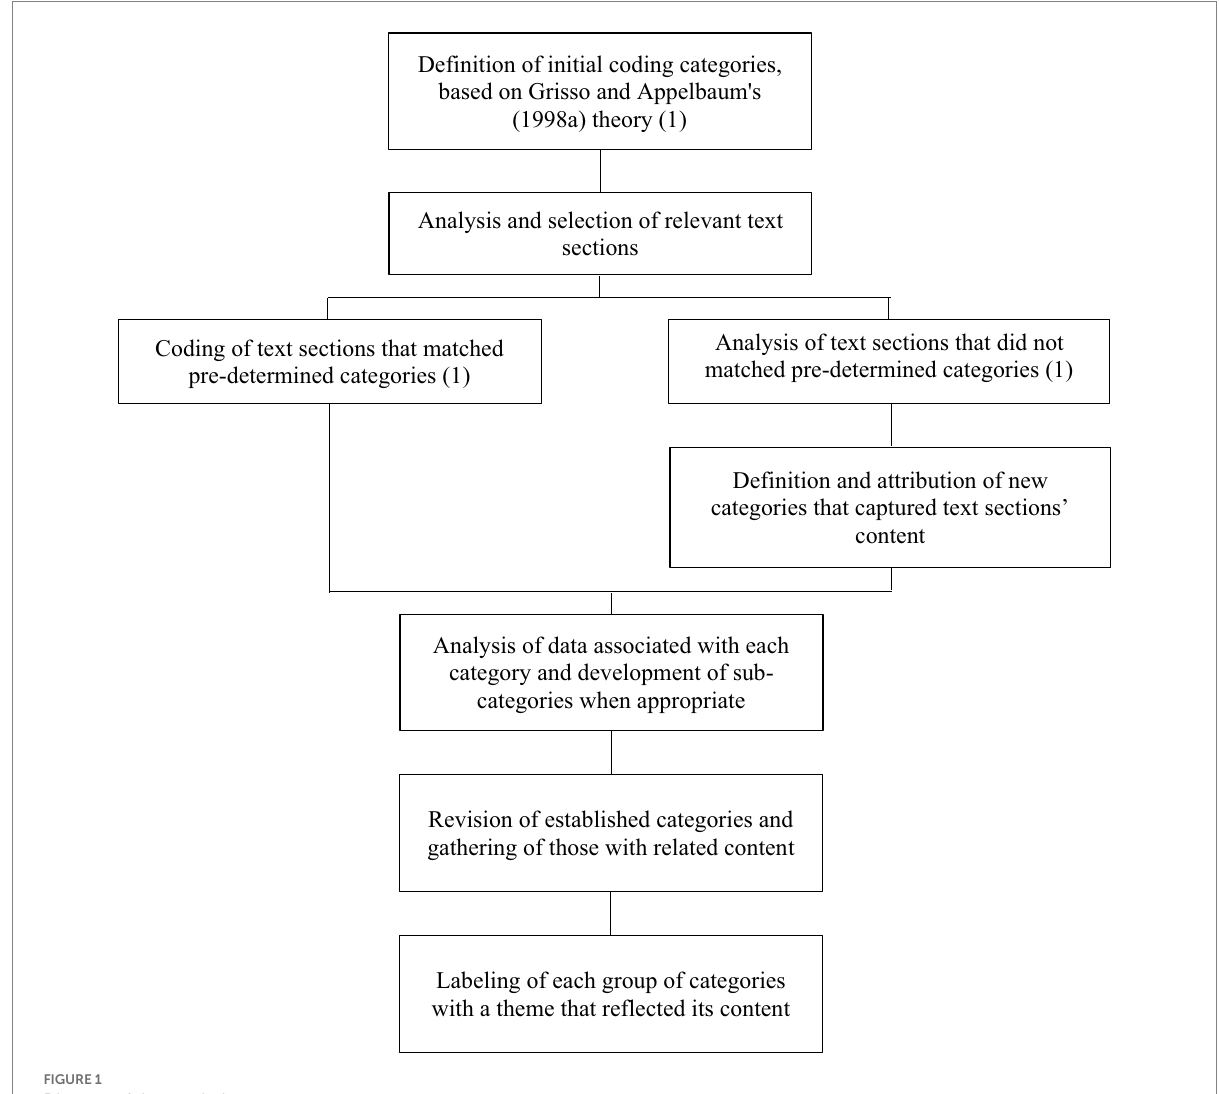
FIGURE 1 Diagram of data analysis